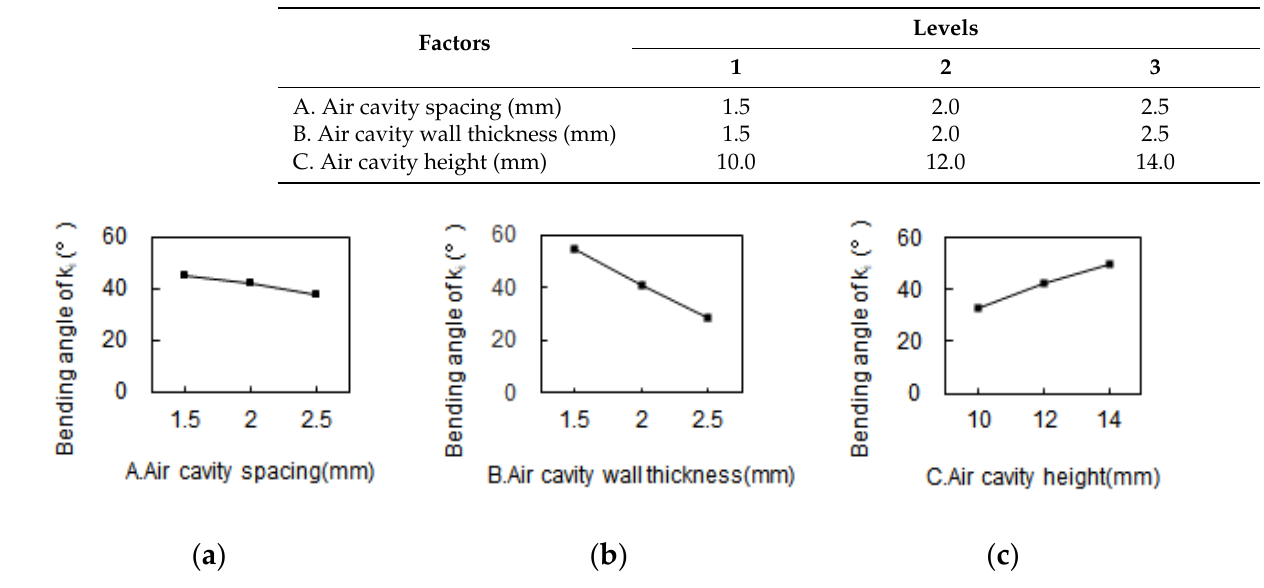
Table 1. Parameter design of the orthogonal test.